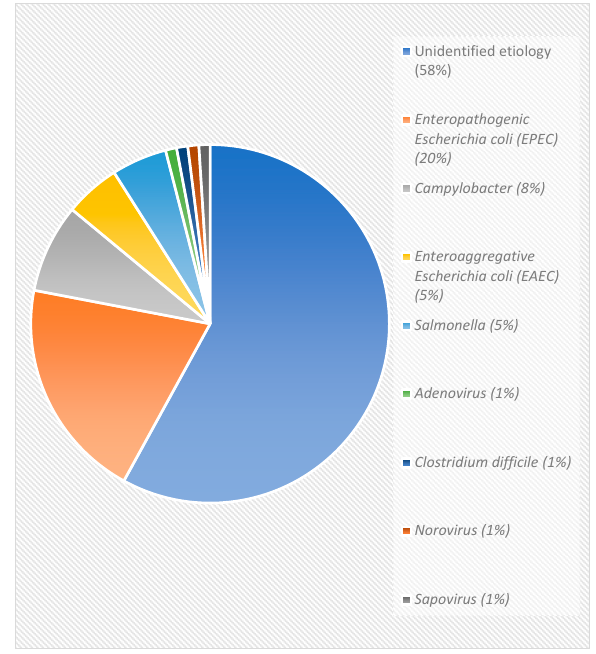
Figure 1. Foodborne pathogens detected using PCR in Trinidad and Tobago, 2018.